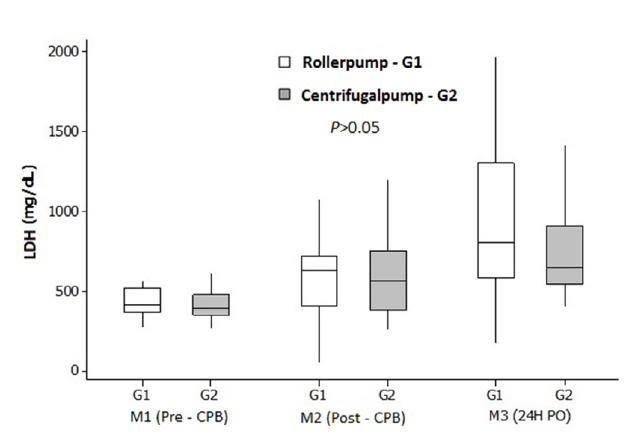
Fig. 1 – Mean (standard deviation) LDH levels, stratified by group and time point.